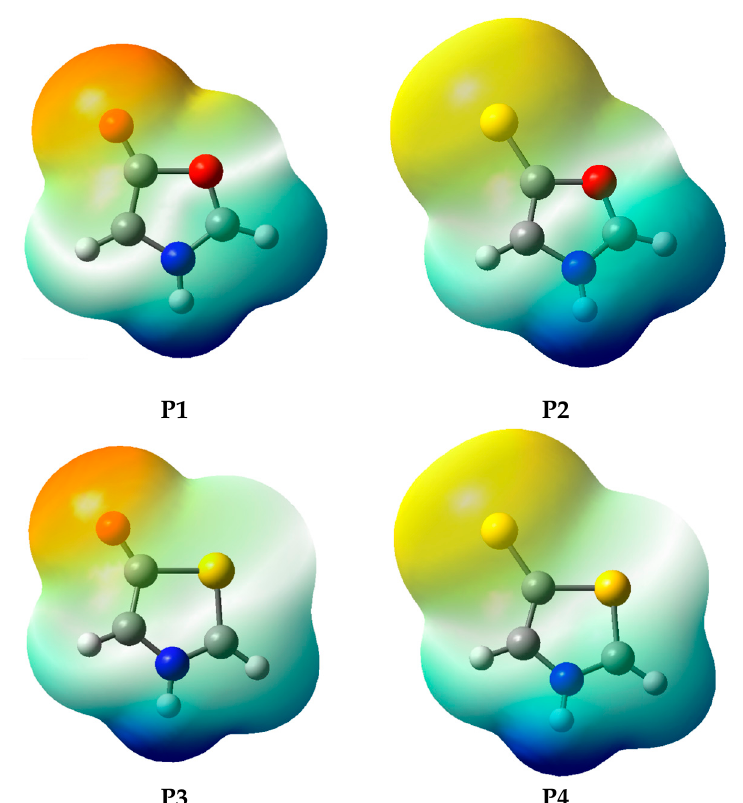
Figure 4. Electrostatic potential map, calculated at the MP2/aug-cc-pVDZ level.